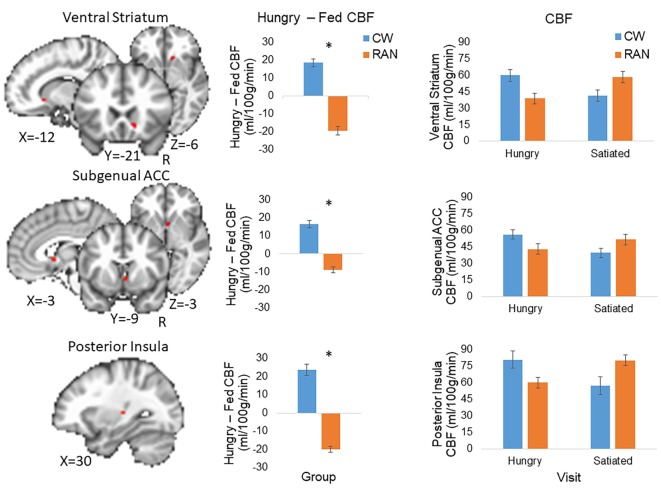
Altered CBF response to hunger in RAN. Student’s t-test results revealed between group differences in the Hungry − Fed contrast within regions of interest (voxel-wise threshold p < 0.001, cluster size corrected for multiple comparisons at p < 0.05). Error bars represent the SE for each group; *p < 0.05. Statistical maps are overlaid onto the MNI152 Harvard-Oxford Atlas 3 mm standard brain. CW, healthy comparison women; RAN, women remitted from anorexia nervosa; VST, ventral striatum; ACC, anterior cingulate cortex; CBF, cerebral blood flow; R, right.